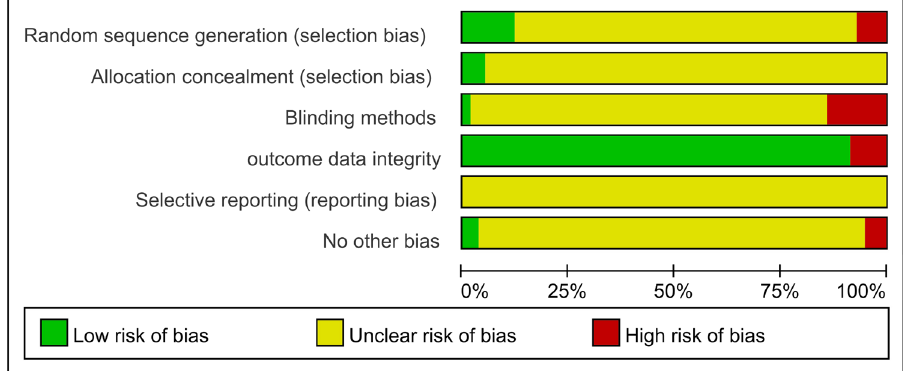
Figure 2. The risk of bias graph.